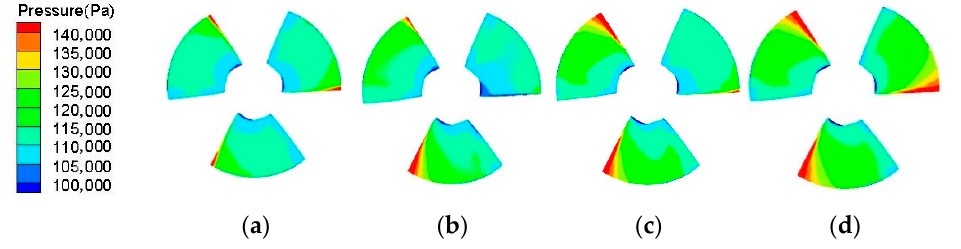
Figure 13. Pump blade frontal pressure distribution of different schemes ( Q = Q des ). ( a ) Scheme I.